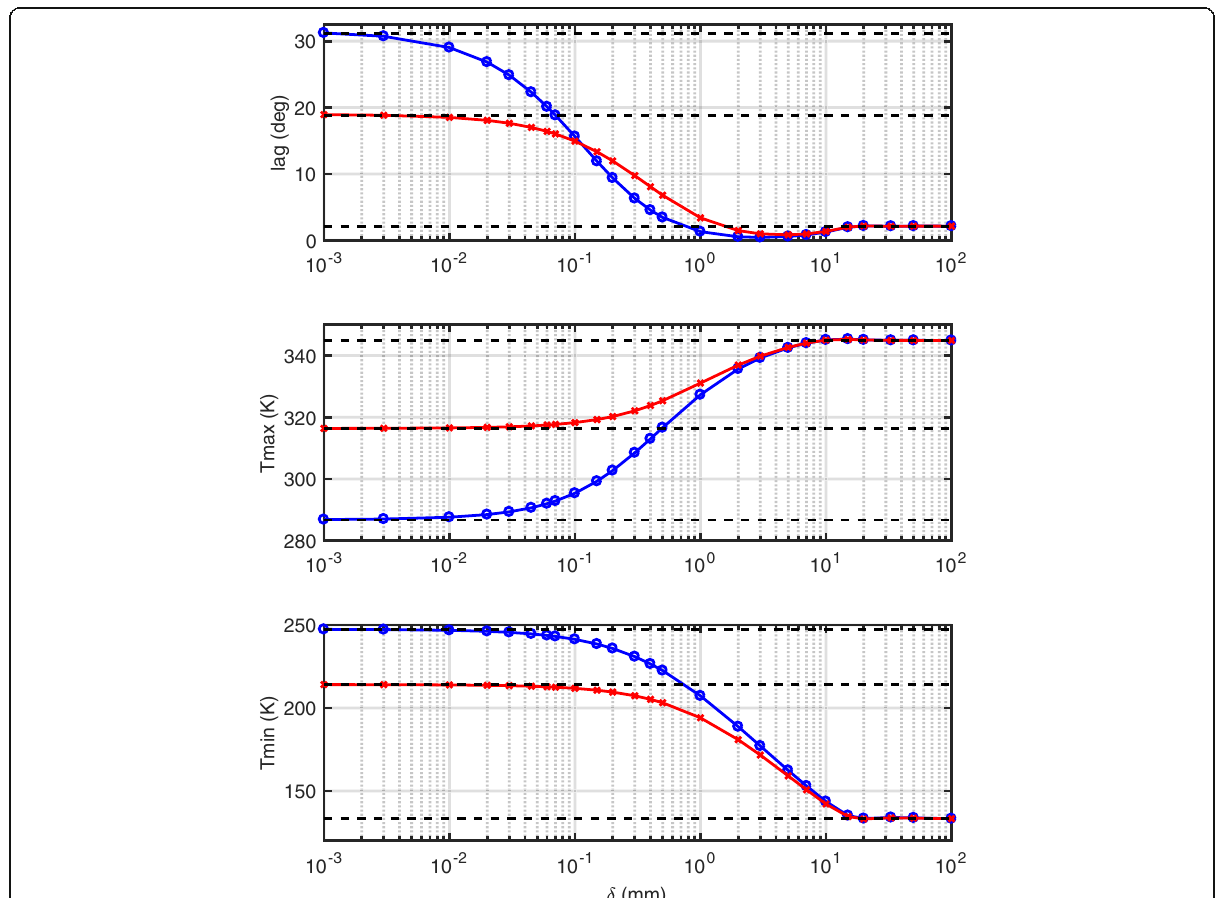
Fig. 3 Phase lag φ , maximum diurnal temperature T max , and minimum diurnal temperature T min as a function of dust thickness δ . The red fit curve corresponds to the case of dust on coarse regolith, whereas the blue fit curve corresponds to dust on bedrock. Broken horizontal lines represent φ , T max , and T min for the homogeneous cases of dust, regolith, and bedrock,